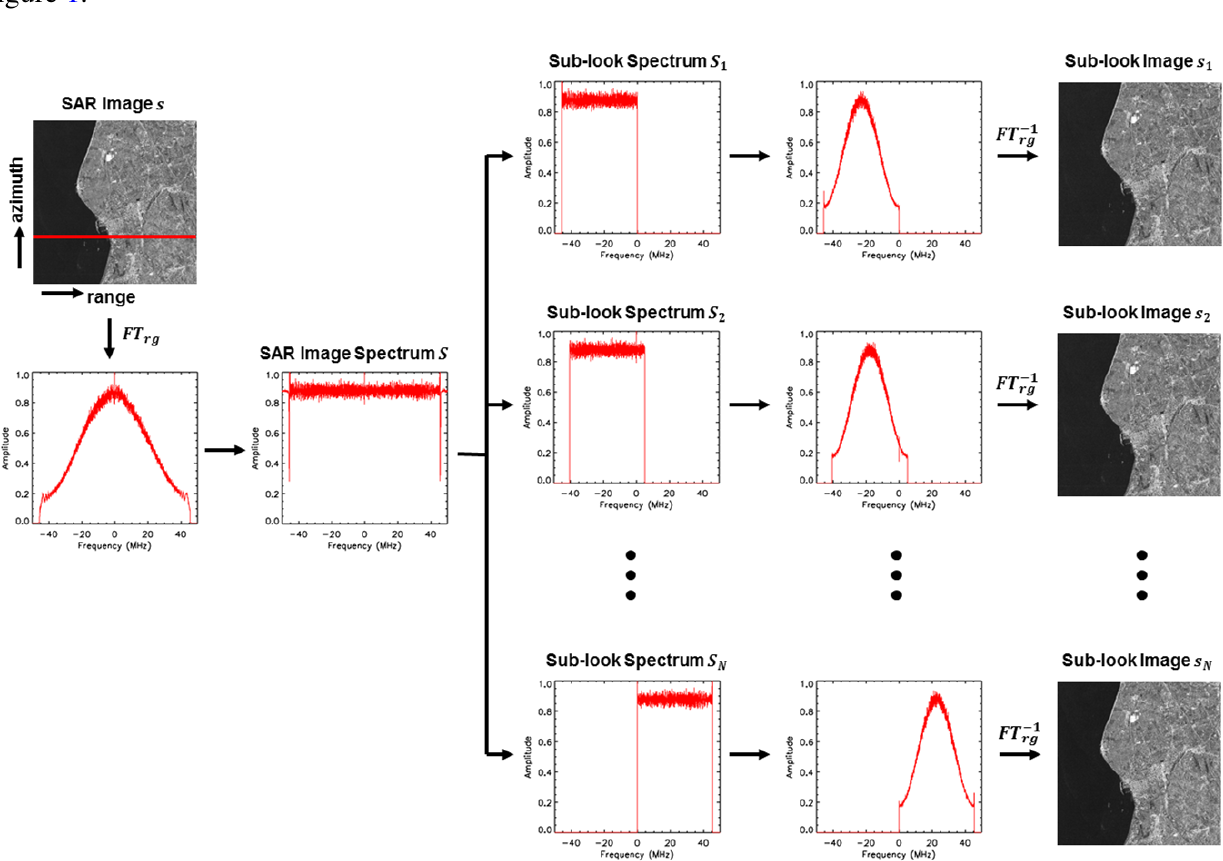
Figure 1. Flow chart of sub-look